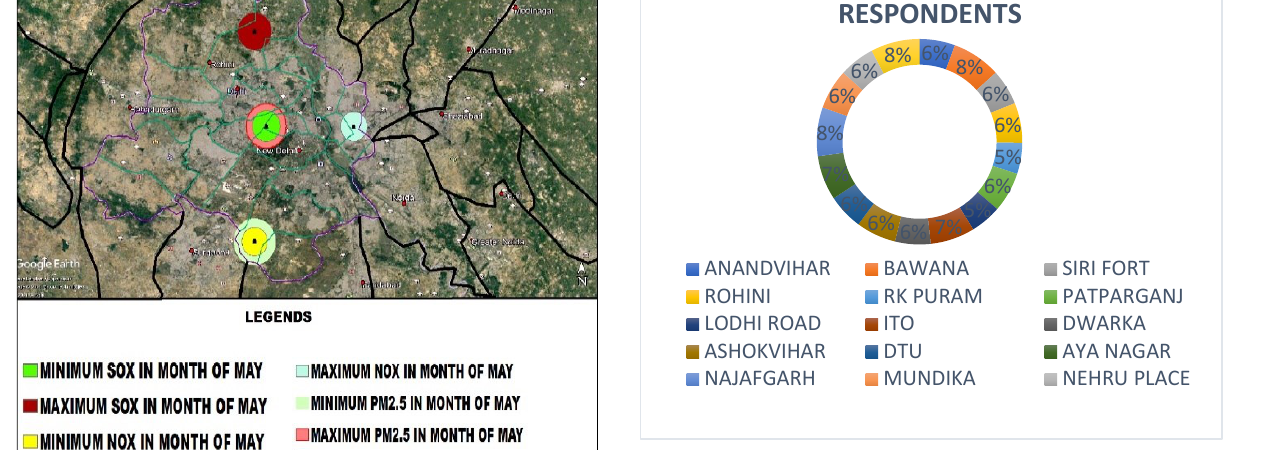
Figure 21. No. of respondents to the survey done in a different part of Delhi in the year 2019